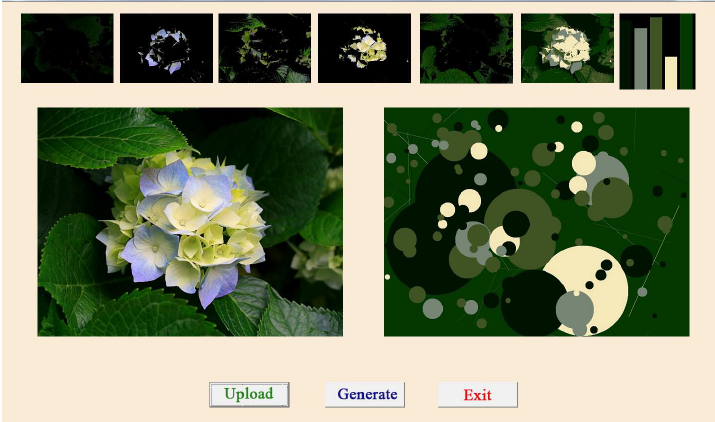
Figure 8. The user interface of application system for computer